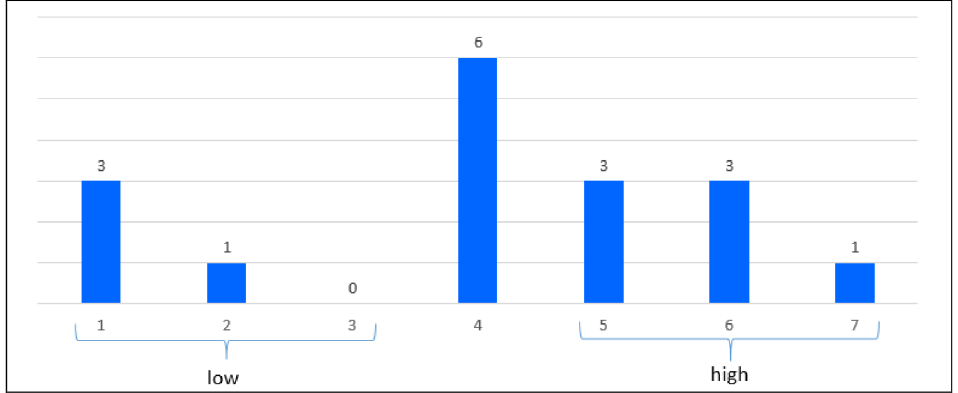
Figure 4. Business associations’